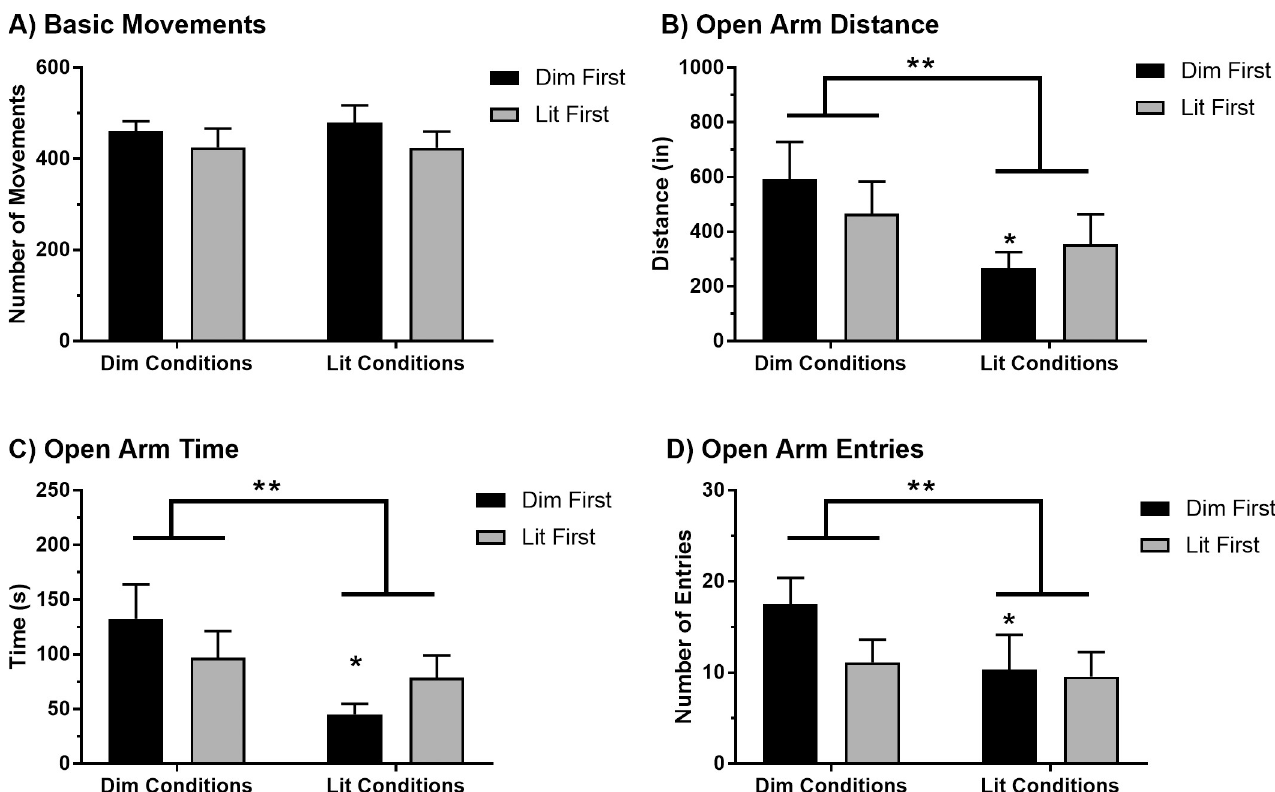
Fig 5. Behavioral performance on the EPM across trials under distinct lighting conditions. Basic movements (A), and open arm distance (B), time (C) and entries (D) across two trials conducted under different lighting conditions. Data are presented as the mean and standard error (Dim First: N = 6; Lit First: N = 7). A significant difference between lighting conditions is denoted by double asterisks ( �� ) and a significant effect of trial order is denoted by a single asterisk ( �